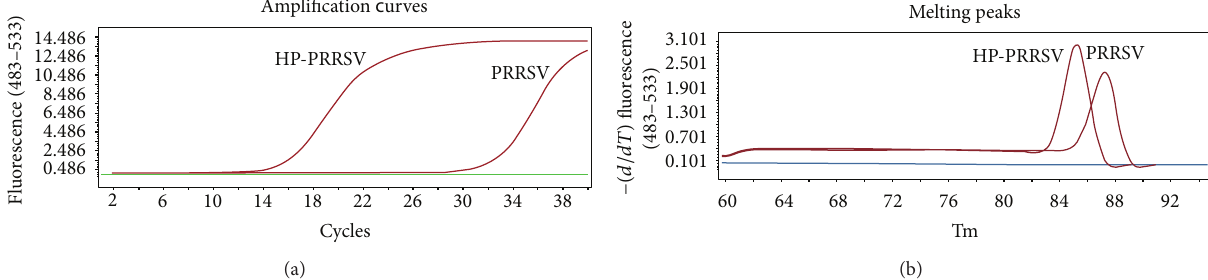
Figure 3: Specific amplification curves and melting curve analysis by SYBR Green I real-time PCR. (a) Specific amplification curves. Fluorescent curves were observed when HP-PRRSV (GD) and PRRSV (CH-1a) were used as templates; no fluorescent signals were observed when the templates were other viruses and host cells. (b) Melting curves. Tm of HP-PRRSV = 85.17±0.12 ∘ C; Tm of PRRSV = 87.27±0.07 ∘ C.